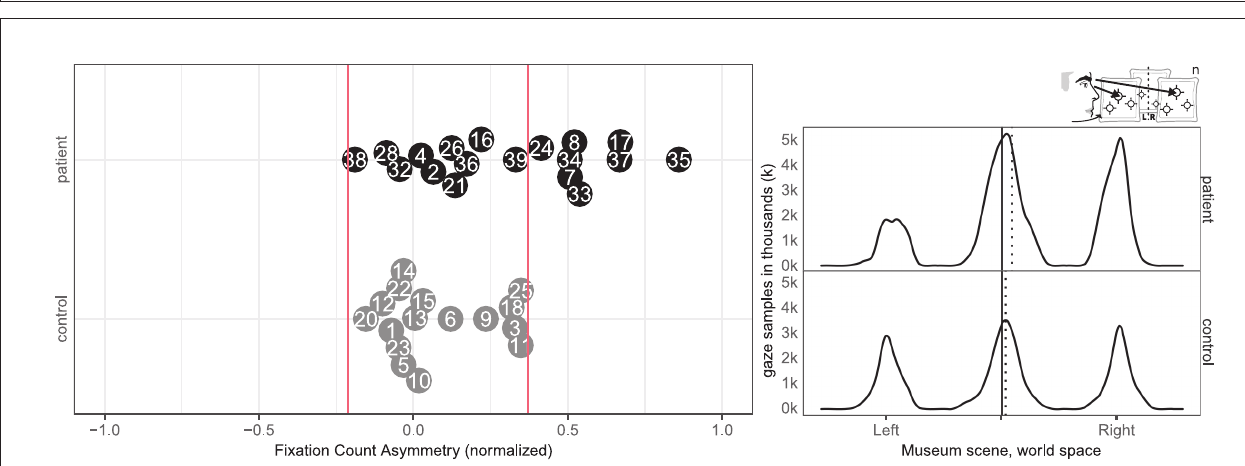
Frontiers in Psychology |